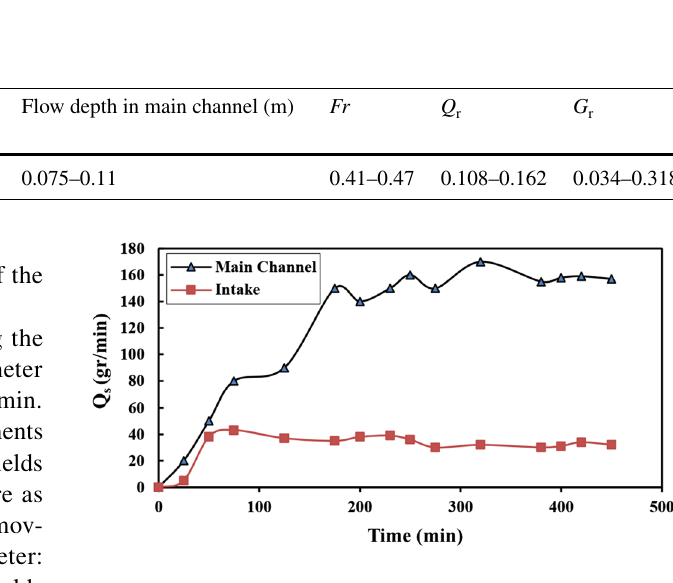
Fig. 5 Sediment discharge changes in